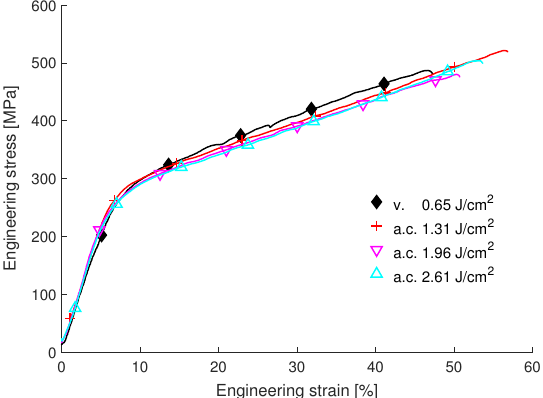
Figure A1. Influence of the ambient processing conditions on the tensile experiments of Upilex VDA foils. For atmospheric conditions (a.c.) and each fluence value one sample was tested. Comparing samples processed with increasing fluence under a.c. with samples processed under vacuum conditions (v.) does not reveal any influence. The scatter of the data lies within the scatter observed in Figure7.